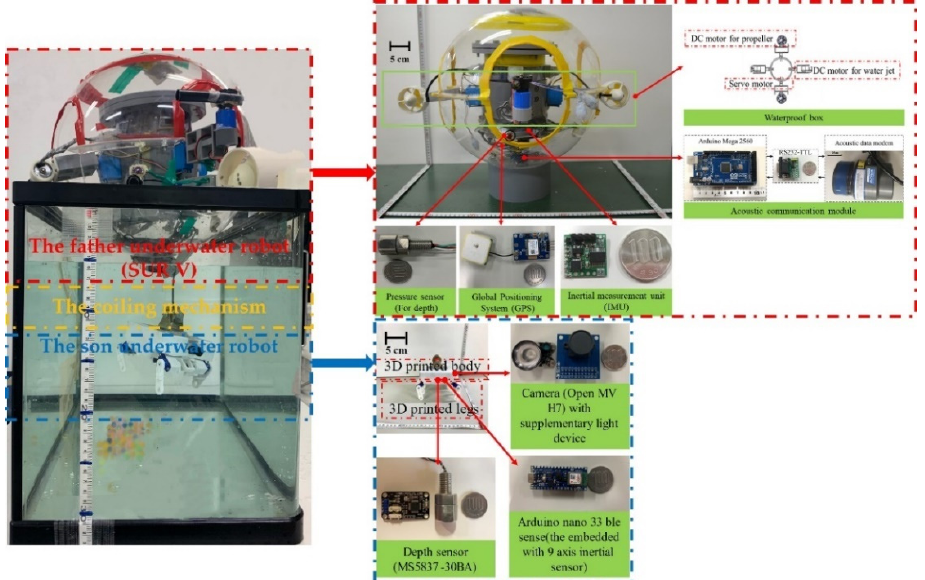
Figure 17. Photograph of the FURS system.